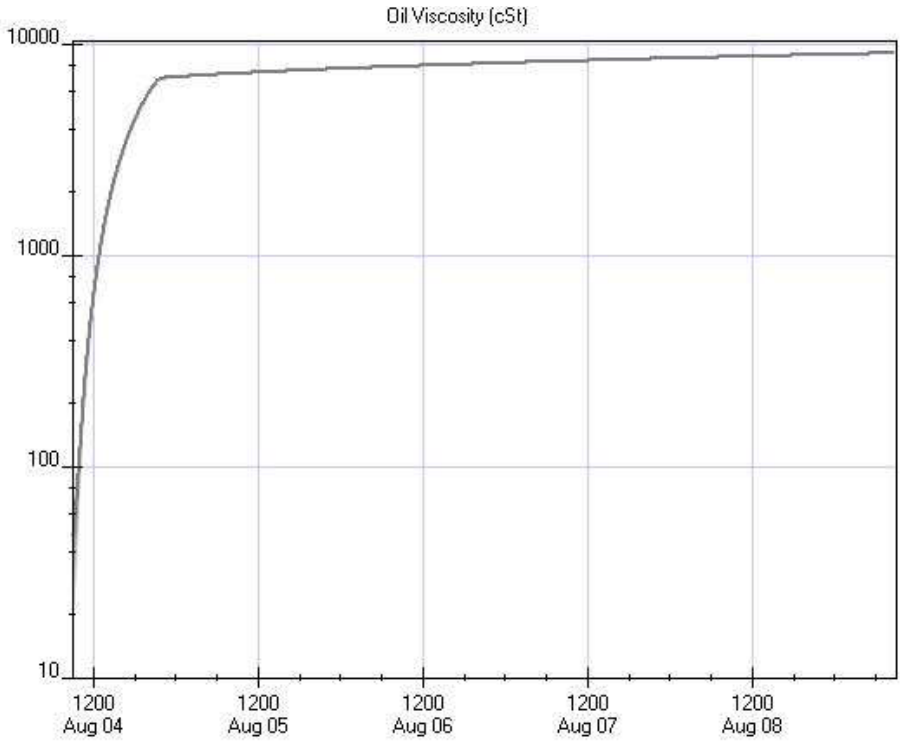
Figure 3. Changes in oil (Arabian extra light (Aramco)) viscosity over time on the surface of water (from the ADIOS program).